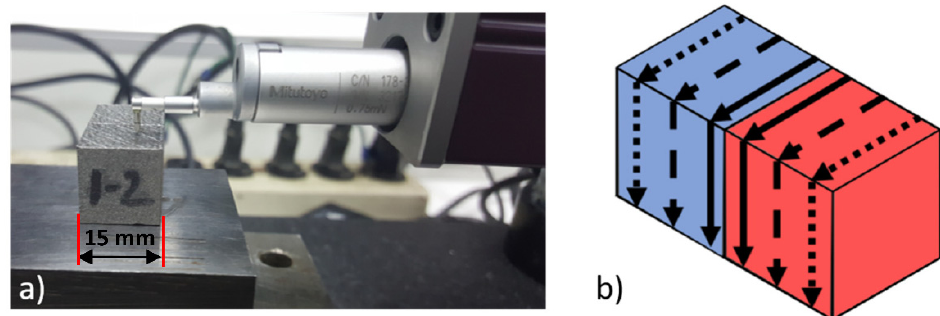
Figure 5. ( a ) Tactile profilometer “Mitutoyo SJ-410”; ( b ) illustration of measurement direction.